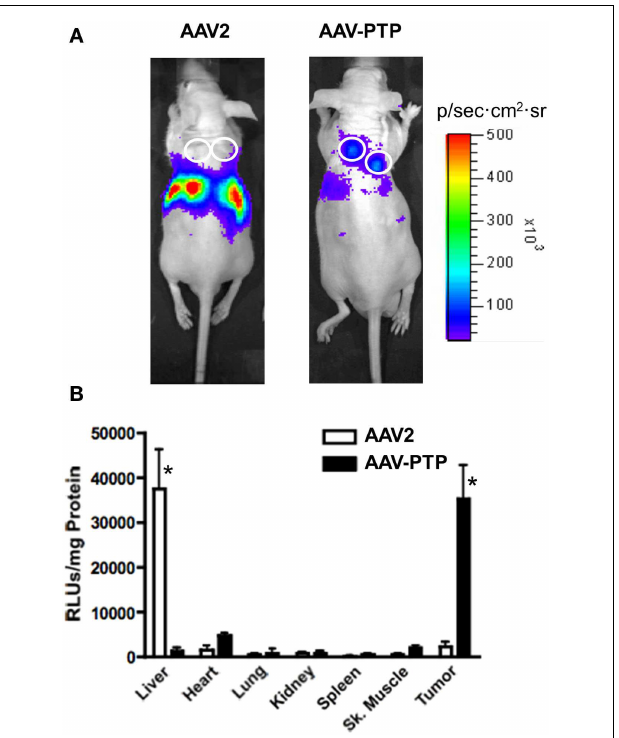
FIGURE 2 |AAV-PTP selectively targets PDAC tumors in vivo . (A) Bioluminescence imaging of mice bearing PANC-1 tumor xenografts. Nude mice bearing PANC-1 tumor xenografts (seven total) were injected intravenously with a single dose (1 × 10 12 vg per mouse) of AAV2 ( n = 3) or AAV-PTP ( n = 4) carrying the ACMVLuc reporter vector genome. Following vector administration, luciferase expression was monitored on days 3,